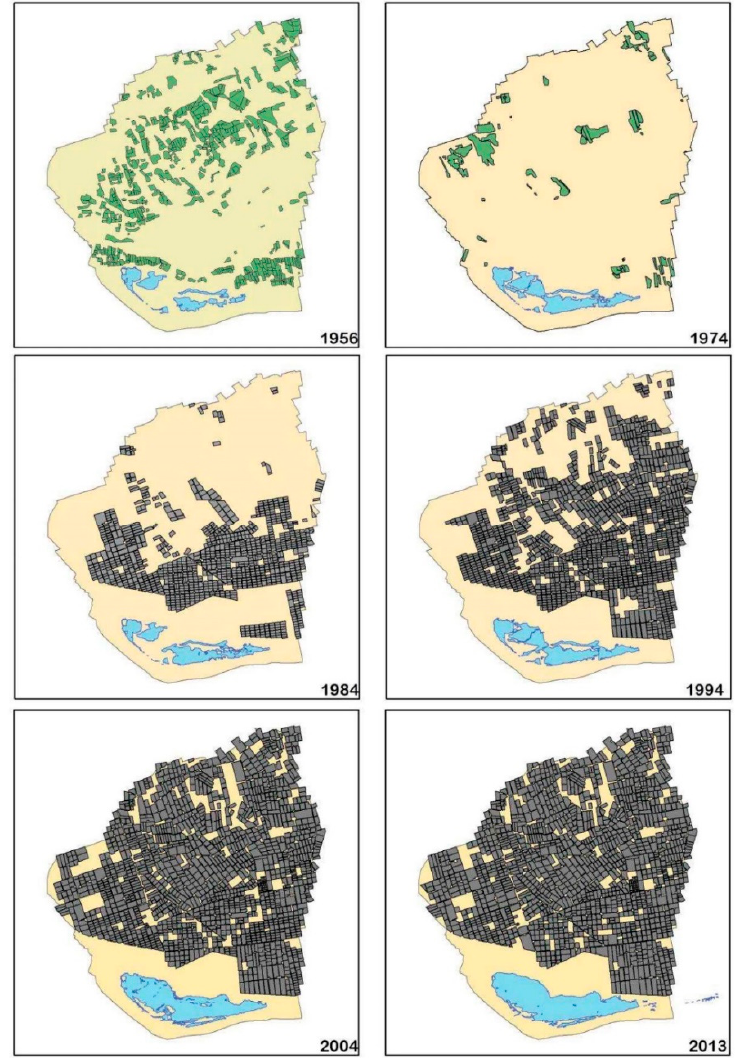
Figure 3. Evolution of the area occupied by greenhouses (gray) and traditional crops (green) and the wetland Puntas Entinas in its drainage basin. The flooded area of the wetland is shown (blue). Modified from [28].